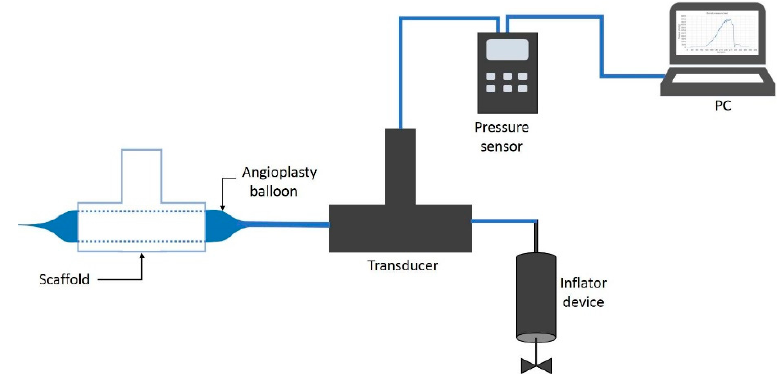
Figure 11. Burst pressure test system.